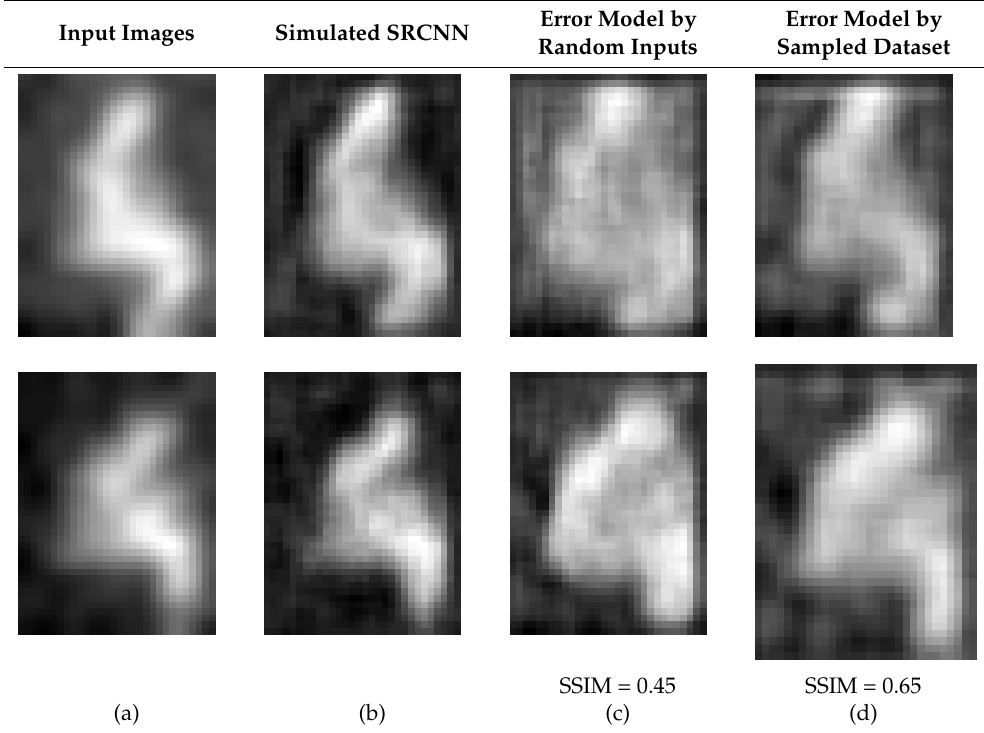
Table 4. SRCNN results under different error